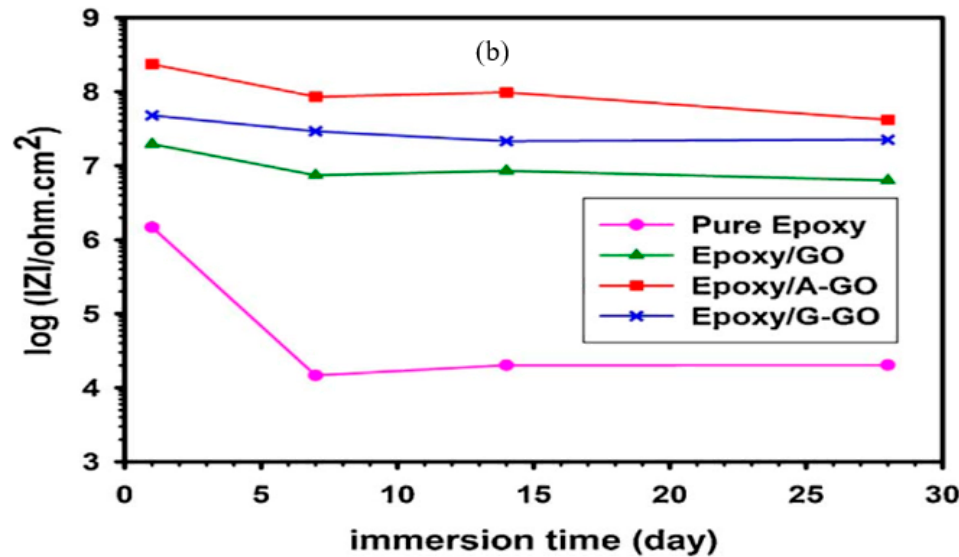
Figure 10. ( a ) Impedance (|Z|) at the lowest frequency (10 mHz) extracted from Bode plots for neat PU, GO/PU and fGO/PU after immersion for different durations in 3.5 wt% NaCl [84] and ( b ) evolution of |Z| for pure epoxy and GO-nanocomposite-impregnated epoxy coatings during immersion in 3.5 wt% NaCl solution for 28 days [85].